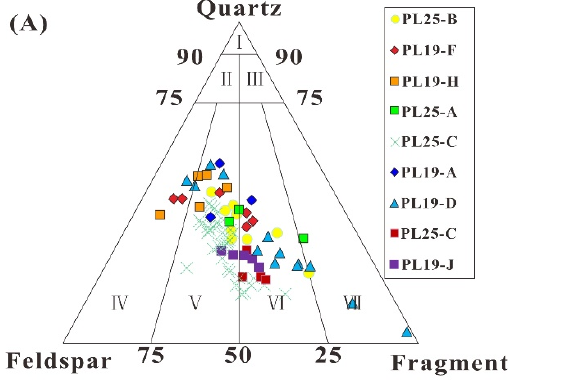
Figure 3. Mudstone color of well PL − 19 − H. ( A ) Gray mudstone, L124, 1713.4 m. ( B ) Light gray mudstone, L100, 1475.3 m. ( C ) Gray green mudstone, L50, 1180.5 m. ( D ) Brown red mudstone, L70, 1304.6 m. ( E ) Red mudstone, L120, 1574.8 m.